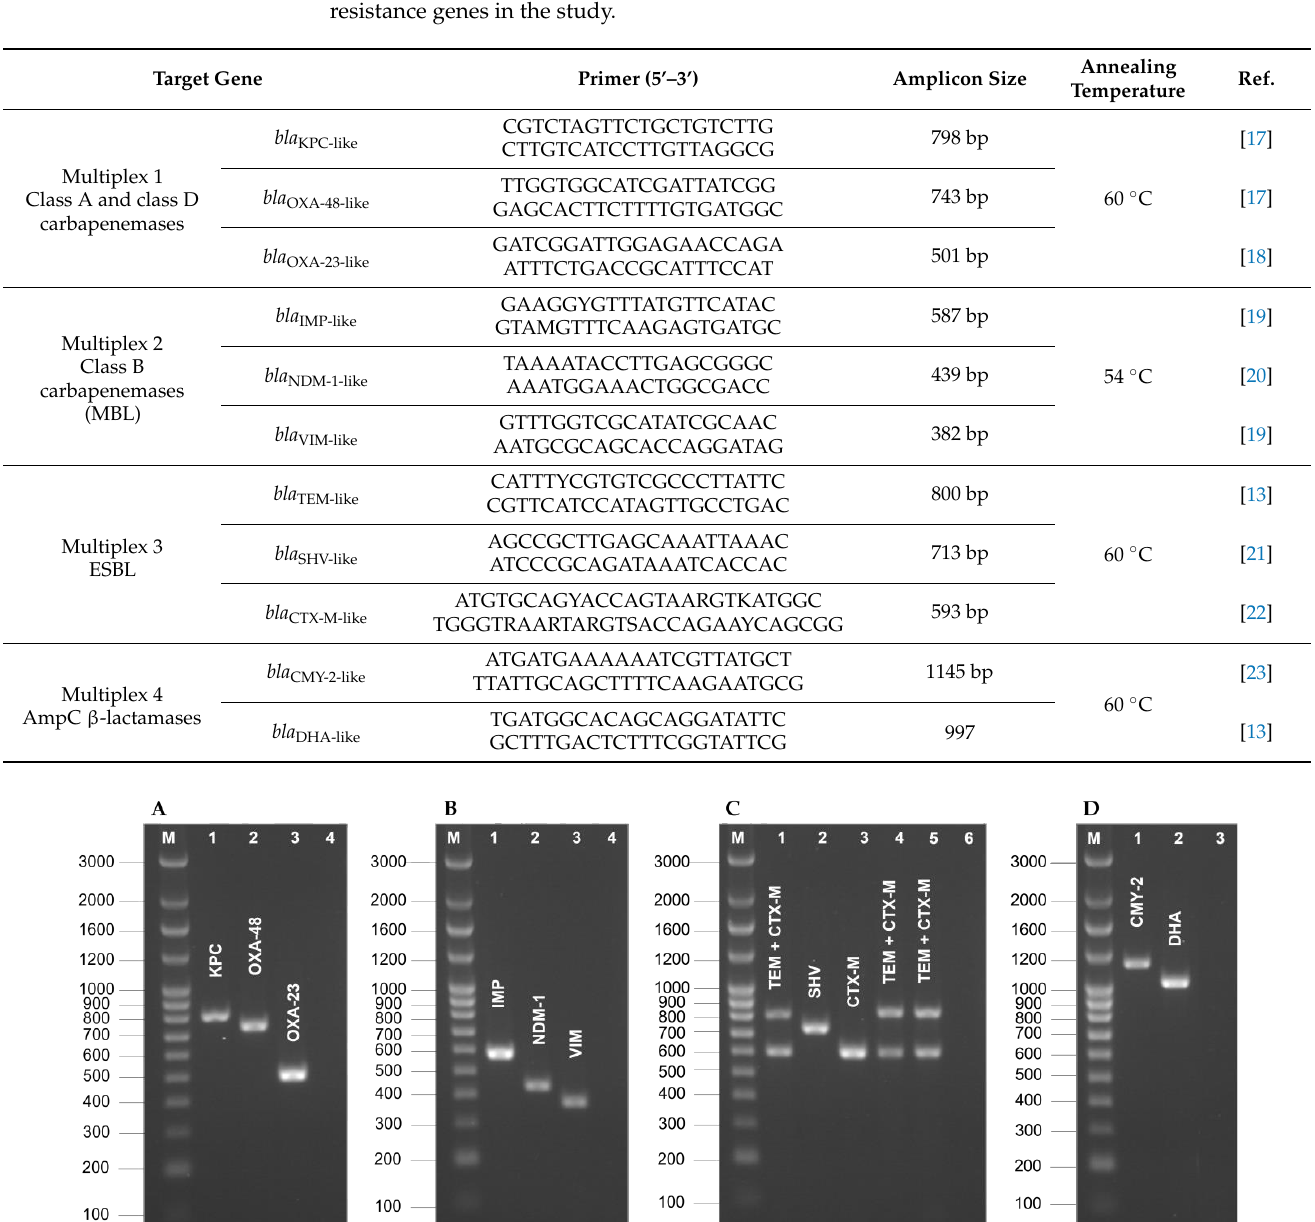
Figure 3. Optimization of the four multiplex PCR assays for the screening of acquired β -lactamases